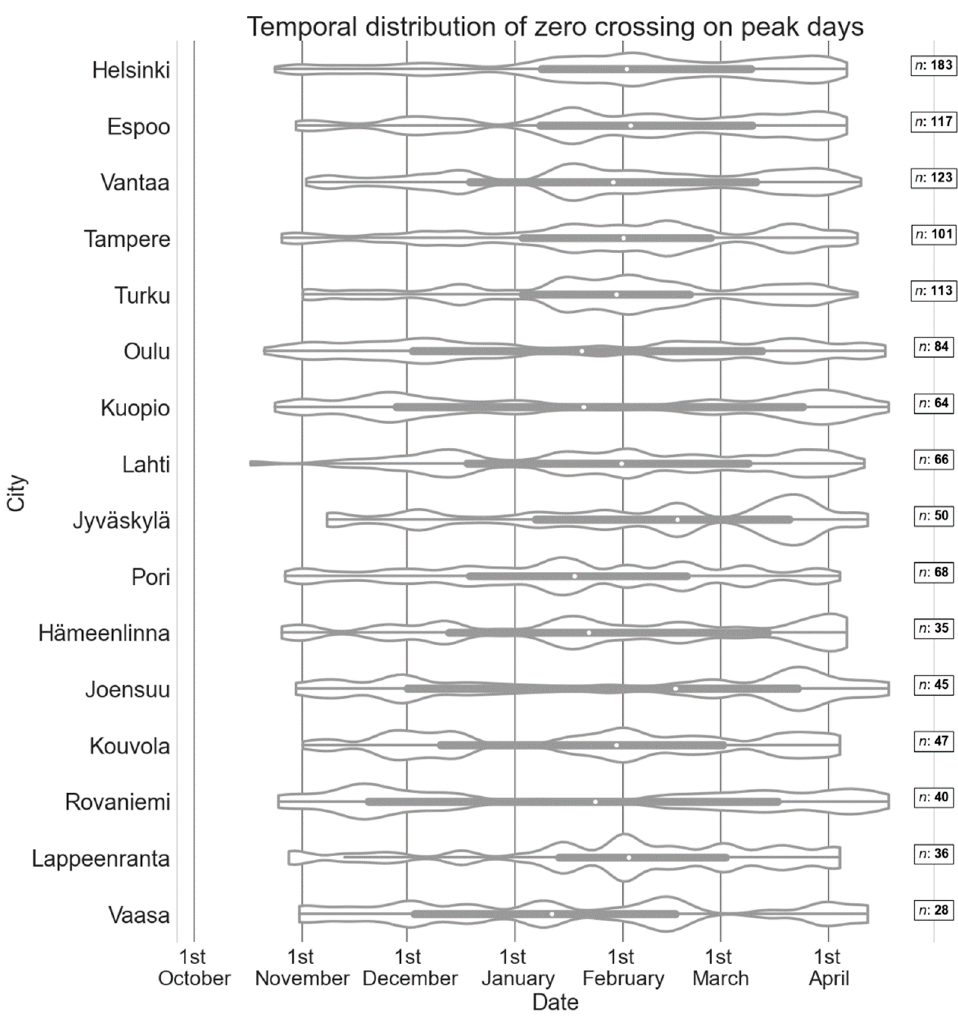
Figure 7. Temporal distribution of the wintertime zero crossings on peak days for all cities between October and April in winter 2005–2019 presented on a violin plot. The width of the span corresponds to the frequency of slip injuries, the wider the distribution is the more slip injuries happen. The white dot within each box represents the median dates of the zero crossings on the peak days. The box spans the 0.25 and 0.75 quantiles, and the whiskers represent the minimum and the maximum dates. Outliers are within the violin plot area. The number of zero crossing days during peak days ( n ) is presented for each city on the right.